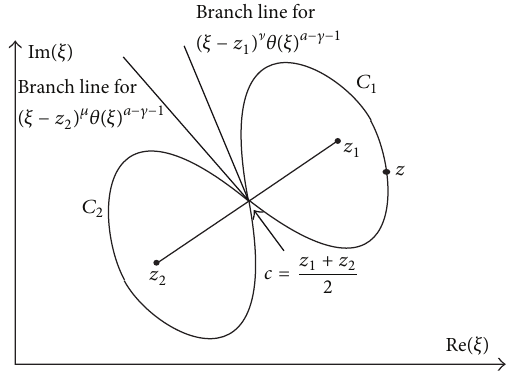
Figure 2: Multiloops